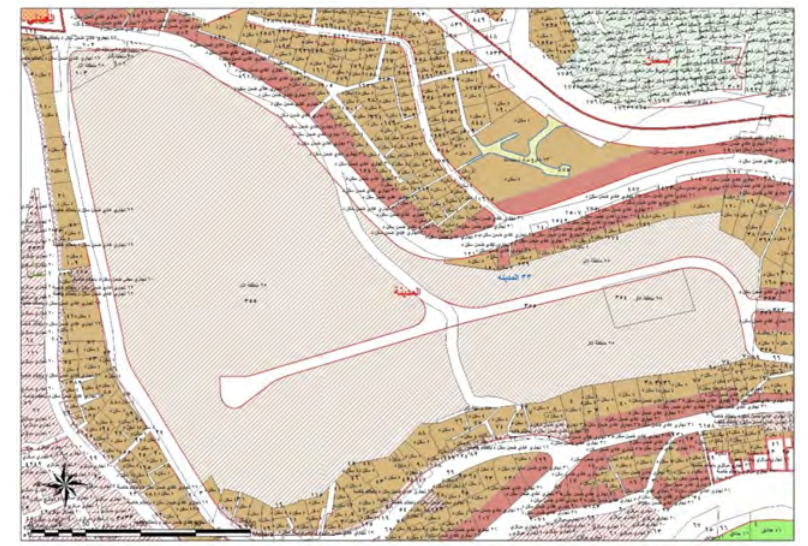
Figure 22. Prohibited area site land use map. Source: GAM- GIS for the author (2016).